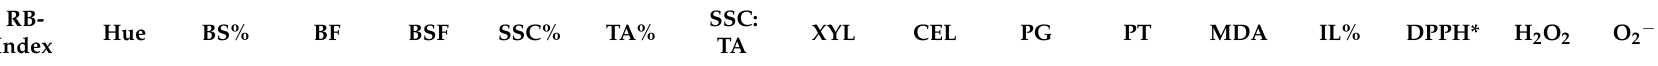
Table 1. Pearson’s correlation pattern among the investigated variables of ‘Crimson Seedless’ grapes that are coated by four levels of mixture